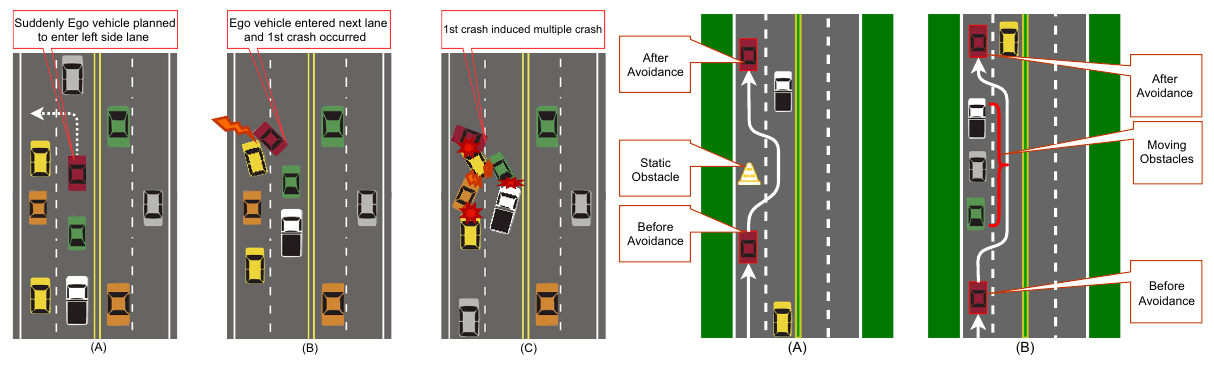
Figure 5. Demonstration of MVCs and its avoidance